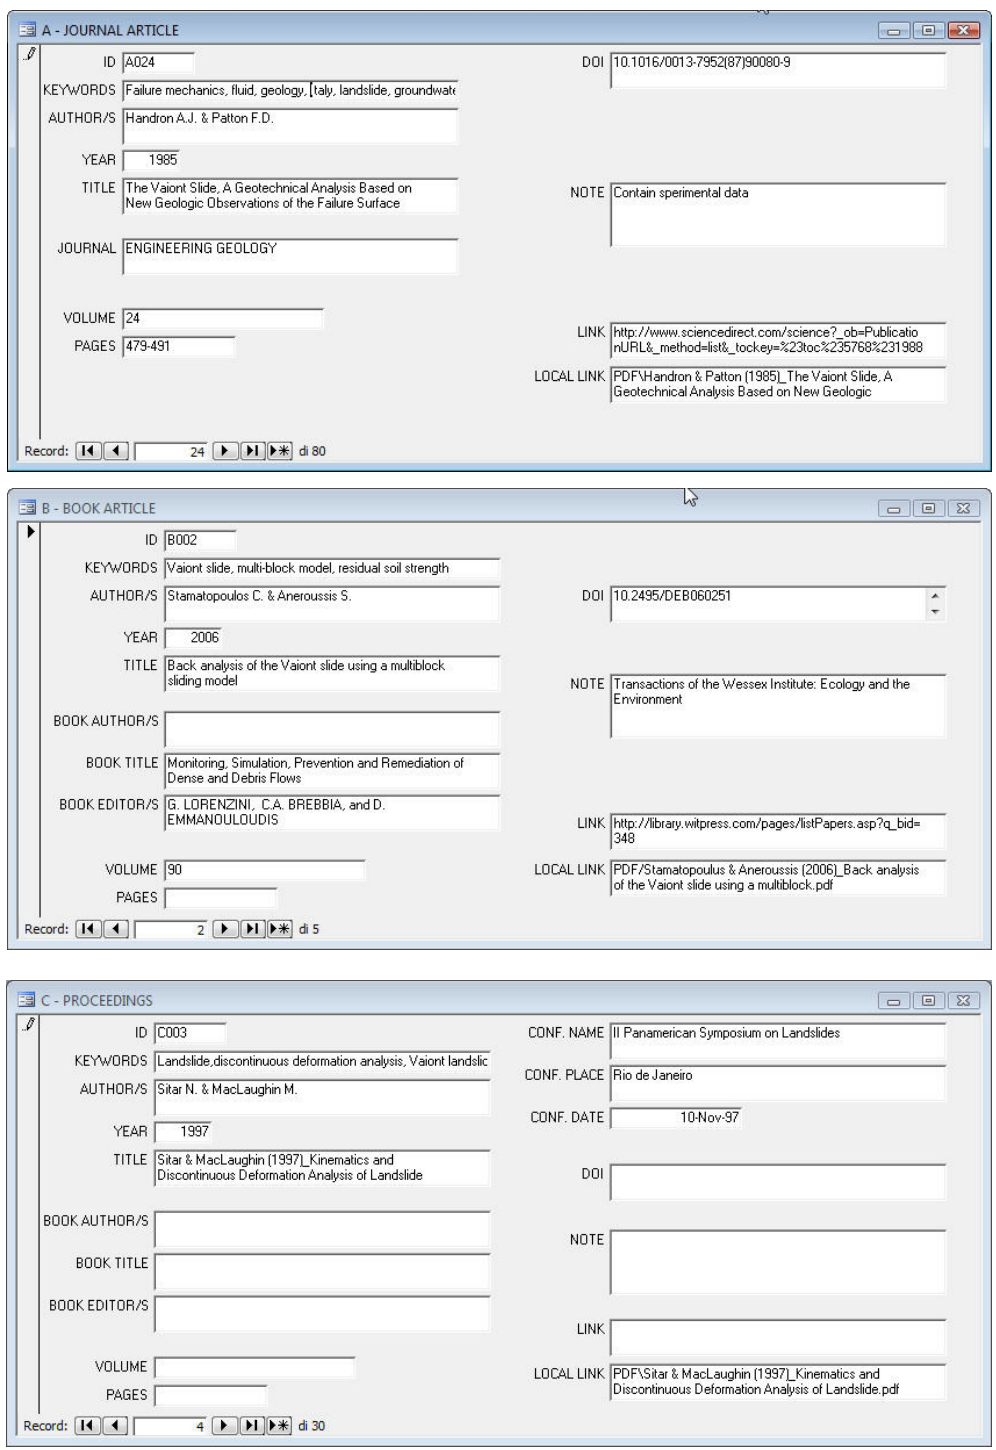
Fig. 3a. Input masks created for inserting and visualizing references to journal articles (A), Book articles (B), Proceedings (C). Input mask of Monographs (D) is similar to that for Book article (B).